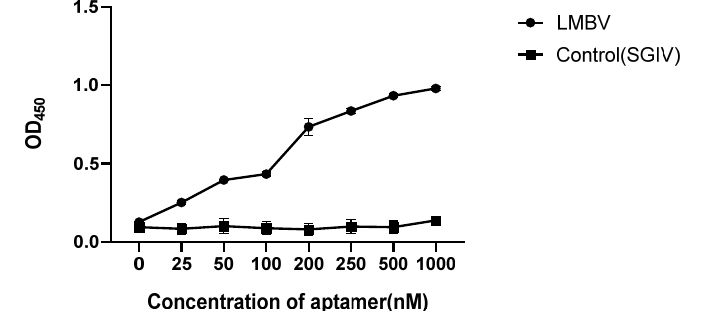
Figure 4. Optimum working concentration of aptamer. The final OD 450 of the sandwich ELASA was detected with different concentrations of aptamers. SGIV was used as controls.